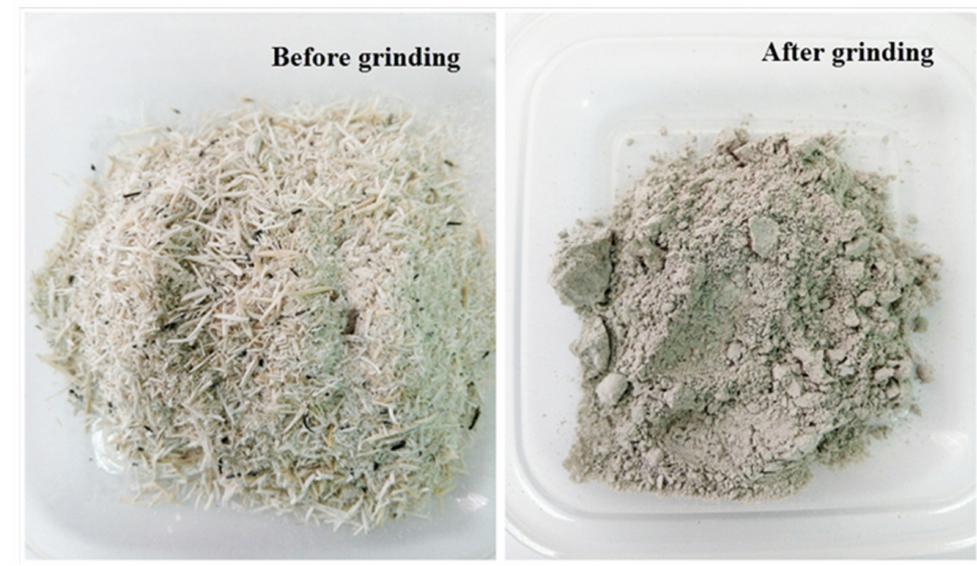
Figure 1. Images of RHA before ( left ) and after ( right ) grinding.